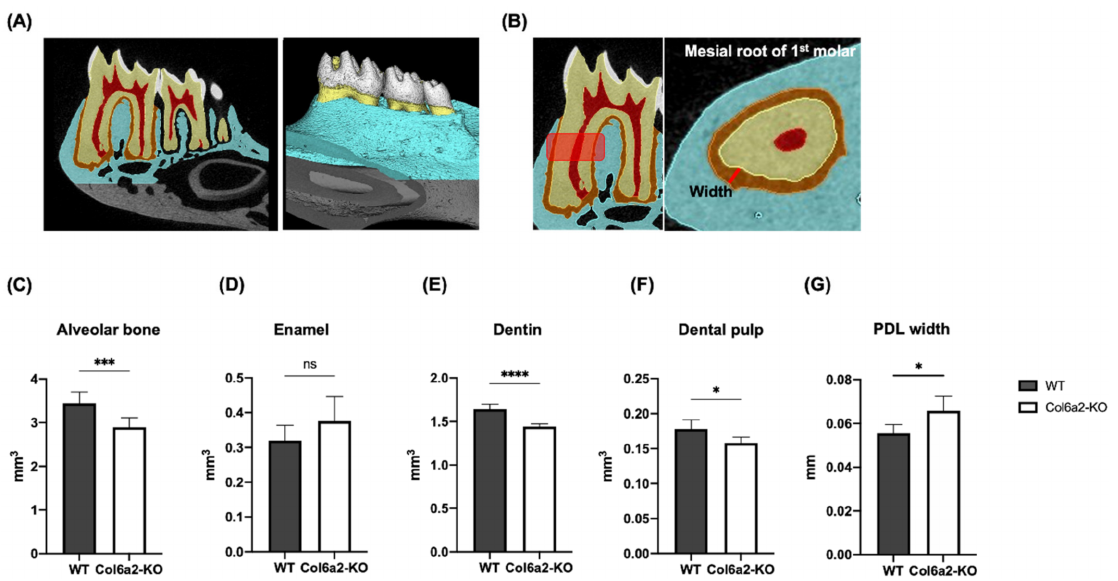
Figure 2. µ CT analysis of the volume and width of the PDL. ( A ) An illustration showing separate analysis of each structure in the oral tissues. Each color represents a different tissue: enamel (white), dentin (yellow), dental pulp (red), PDL (orange) and alveolar bone (blue). ( B ) shows the width of the PDL measured by µ CT. Quantification of the different tissues is shown for alveolar bone ( C ), enamel ( D ), dentin ( E ), dental pulp ( F ). ( G ) The PDL width was measured in the mesial root of the 1st molar. Bars represent standard deviation (volume: n = 7/genotype, PDL width: n = 5/genotype) p -value: